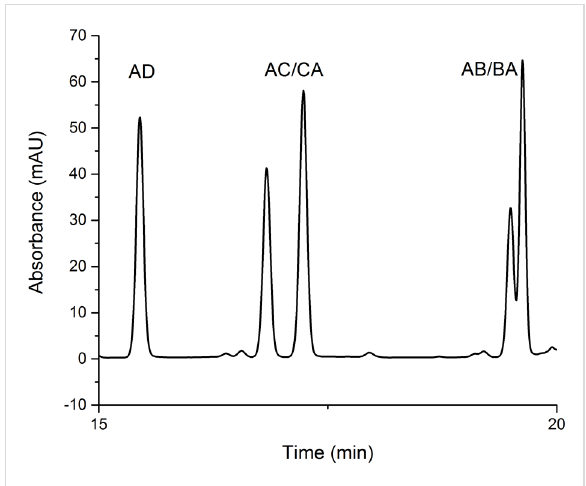
Figure 7: HPLC–MS chromatogram with the separated pseudoenan- tiomers of 6 A -azido-6 B -mesitylenesulfonyl- α -CD 8b and 6 A -azido-6 C - mesitylenesulfonyl- α -CD 8c at 10